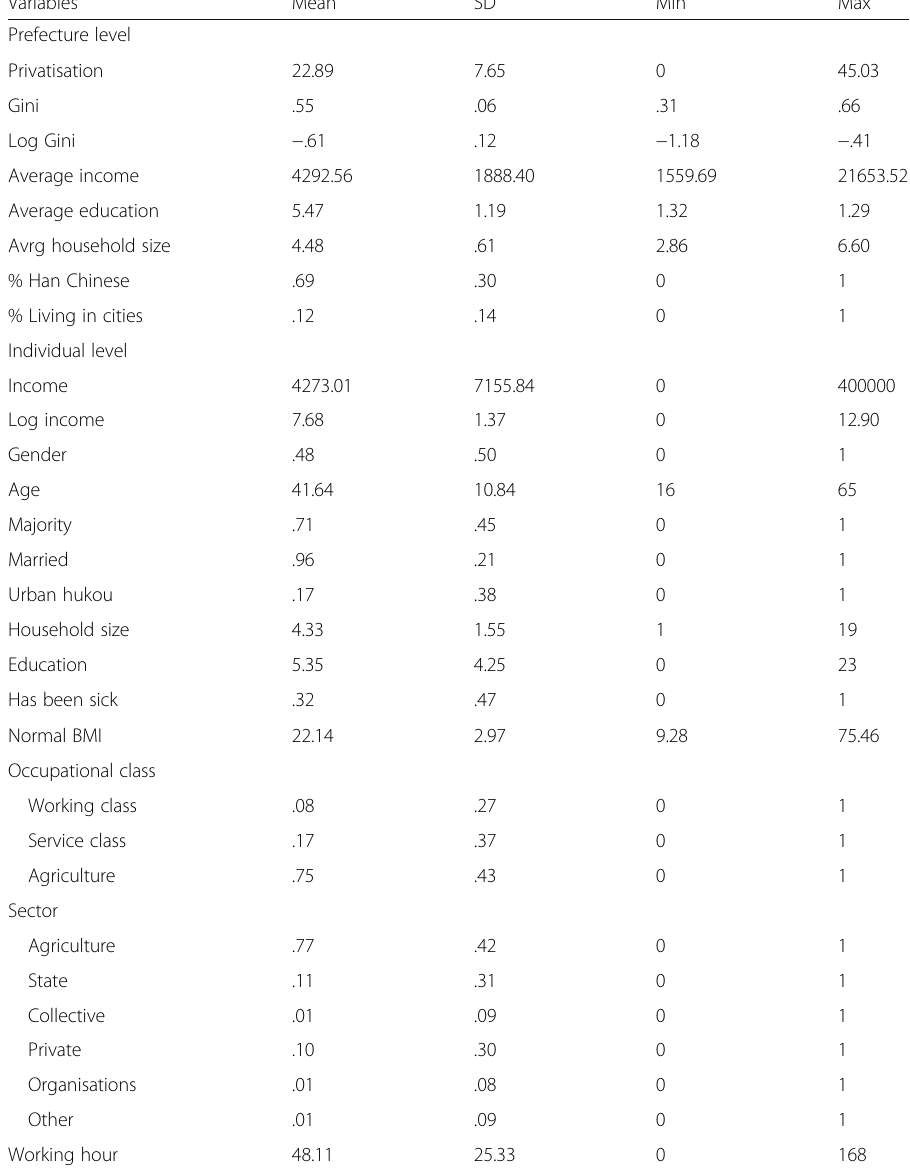
Table 1 Descriptive statistics for the original variables used in multilevel analysis. N = 49,873 Variables